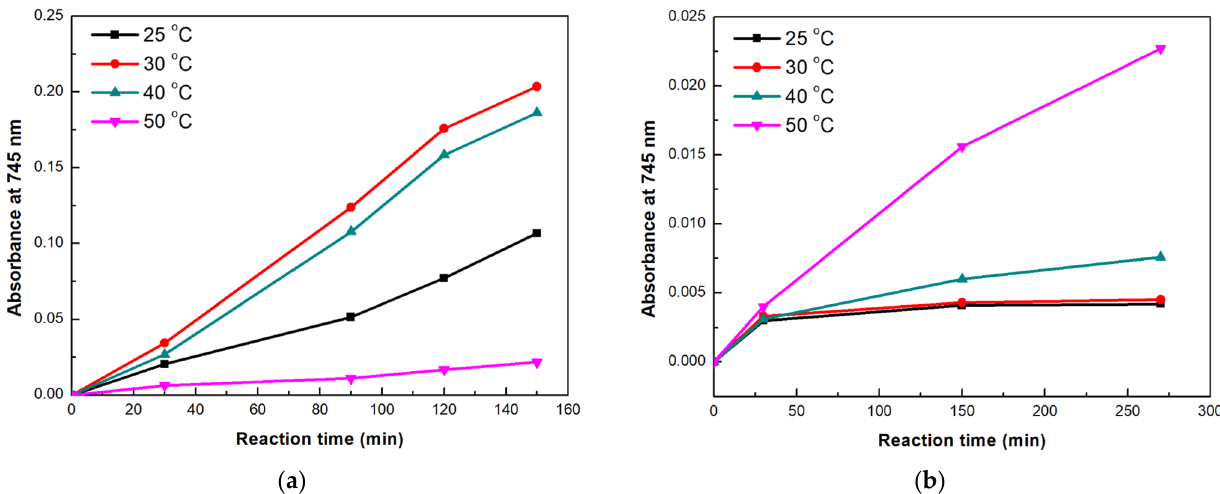
Figure 12. Time-dependent increase in absorption at 745 nm for cascade reactions conducted at different temperatures, using as initial substrate ( a ) p NPG and ( b ) cellobiose. (Standard errors were <0.05 in all cases).